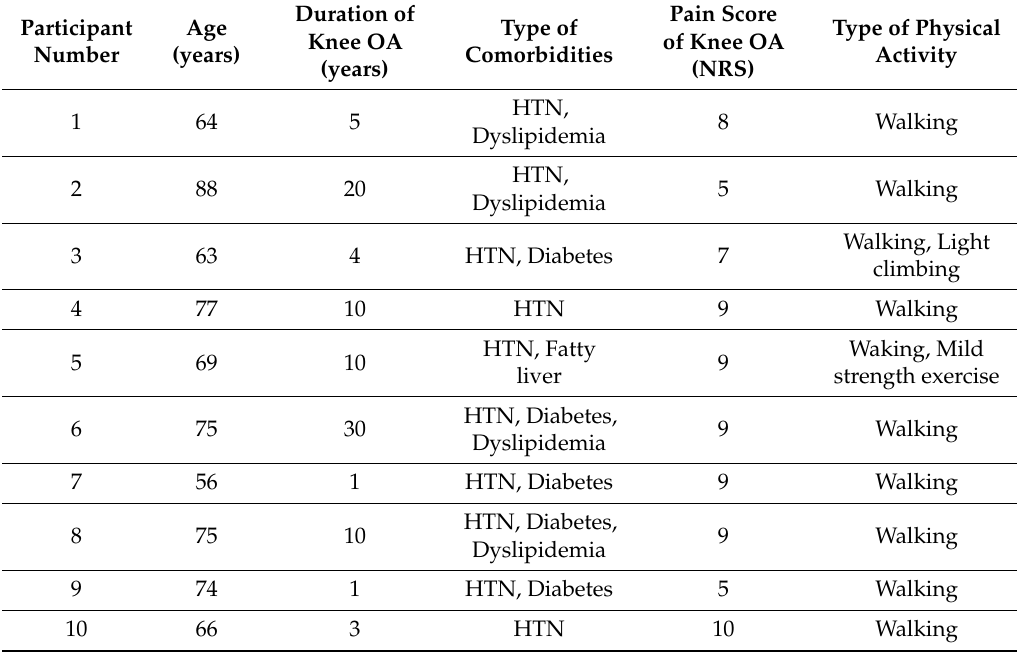
Table 1. Demographic characteristics of participants ( n =